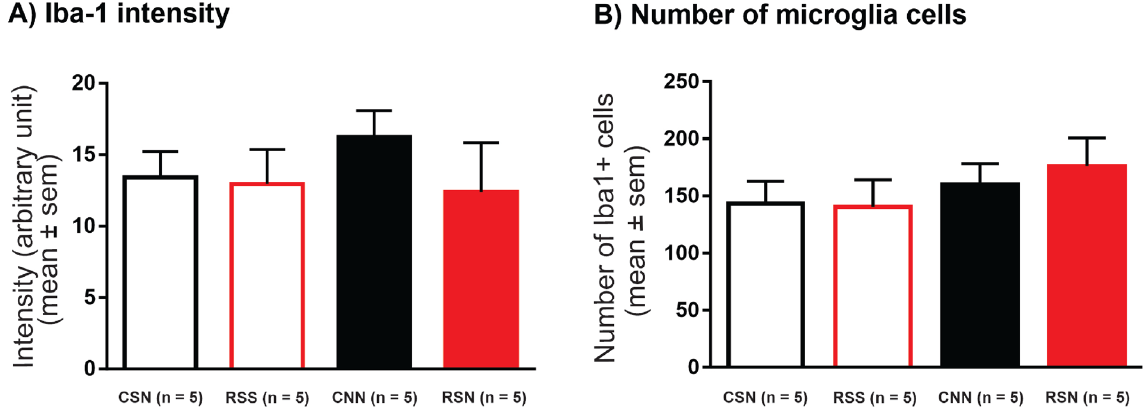
Figure 4. Quantitative analysis of Iba-1 stained microglia cells (ipsilateral side). Repetitive intramuscular NGF injections were associated with a small increase in Iba-1 staining intensity while NGF preceded by adolescent stress was associated with a small increase in number of microglia cells. ( A ) Intensity of Iba-1 stained microglia cells shown in arbitrary unit. Data expressed as mean ± SEM (based on n = 5 animals/group). Intensity and background was measured for each ROI. The background was subtracted and the mean staining intensity was calculated. ( B ) Number of Iba-1 stained microglia cells and data expressed as mean ± SEM. Iba-1 stained microglia cells were counted in each ROI (256 × 256 µm 2 , 20 µm slice thickness, 1.31 nl volume) and the mean was calculated. Iba-1, ionized calcium binding adapter molecule 1; ROI, region of interest; NGF, nerve growth factor. CSN: control + saline + NGF; RSS: repeated restraint stress + saline + saline; CNN: control + NGF + NGF; and RSN: repeated restraint stress + saline + NGF.